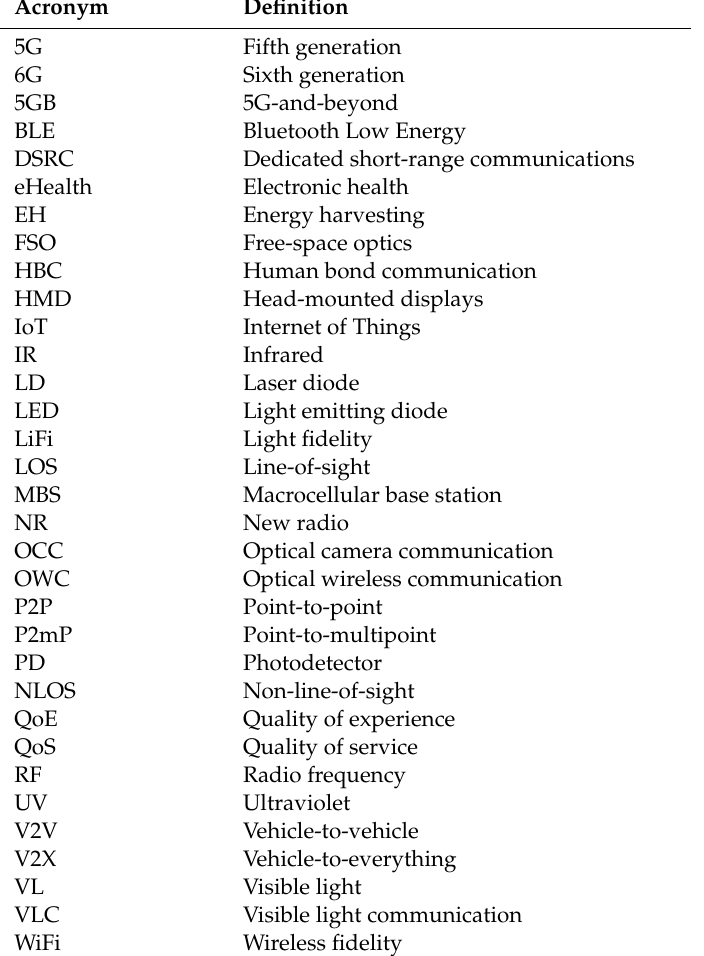
Table 1. List of